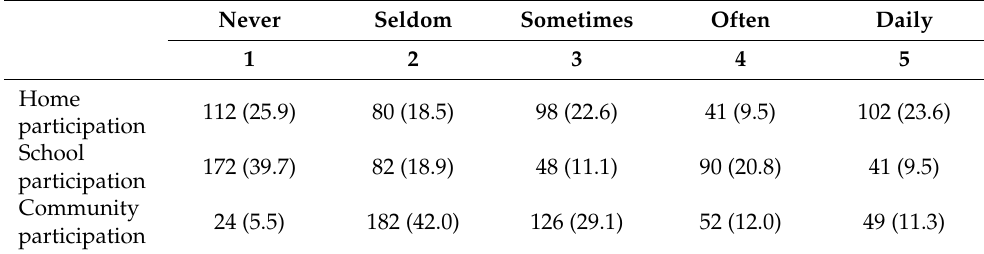
Table 3. Participation of children with disabilities (N = 433).